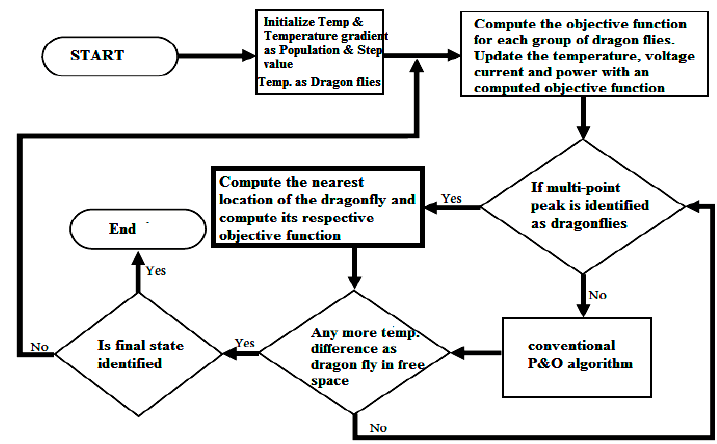
Figure 6. Flowchart of the dragonfly algorithm.